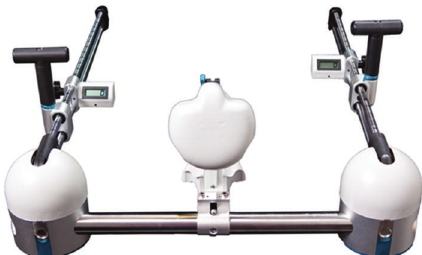
Figure 2: Tailwind. Reprinted with permission (http://www.tail- windtherapy.com/).